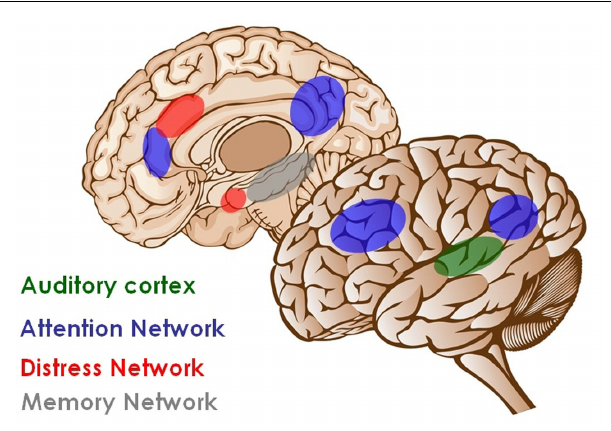
FIGURE 1 | Brain networks involved in tinnitus. Auditory deafferentation causes neuroplastic changes resulting in increased activation of the primary auditory cortex (green). Awareness of the stimulus arises when this activity is connected to a larger co-activated awareness or perceptual network.This perceptual network involves anterior and posterior cingulate cortex, precuneus, parietal cortex, and frontal cortex (blue). As a consequence of a constant learning process, the phantom percept becomes associated to distress, which is reflected by a non-specific distress network consisting of the anterior cingulate cortex, anterior insula, and amygdala (red).The persistence of the phantom percept is due to memory mechanisms involving the parahippocampal area, amygdala, and hippocampus (gray; modified from De Ridder et al., 2011a).